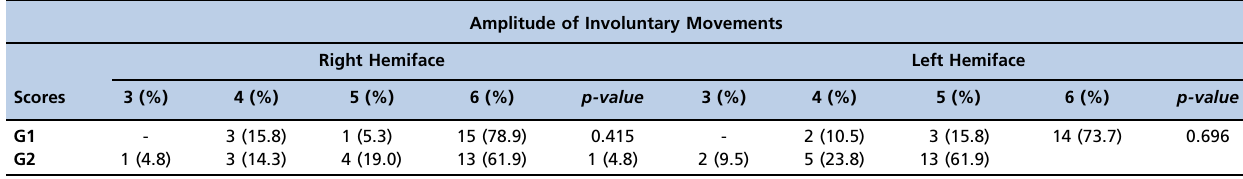
Table 4 - Evaluation of involuntary facial movements in deep partial-thickness burns – G1 (n=19) and full-thickness burns – G2 (n=21). Amplitude of Involuntary Movements Right Hemiface